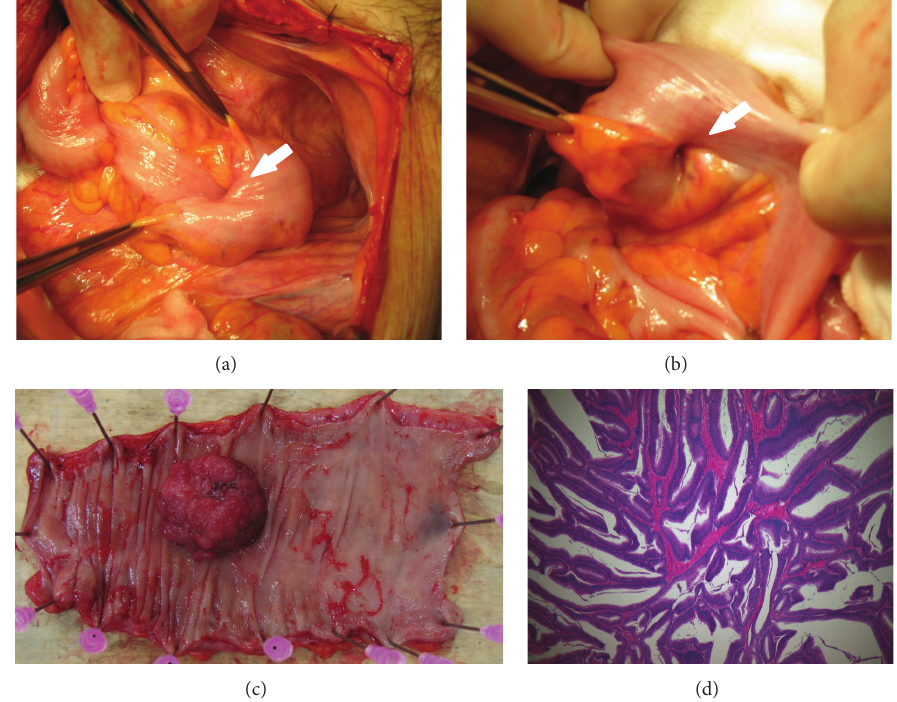
Figure 4: Intussusception of the rectosigmoid colon (a). Suspected area of subserosal invasion (b). Resected specimen with type 1 tumor (35 × 40 mm) (c). Pathological examination revealed a well-differentiated adenocarcinoma with subserosal invasion. Original magnification 40x